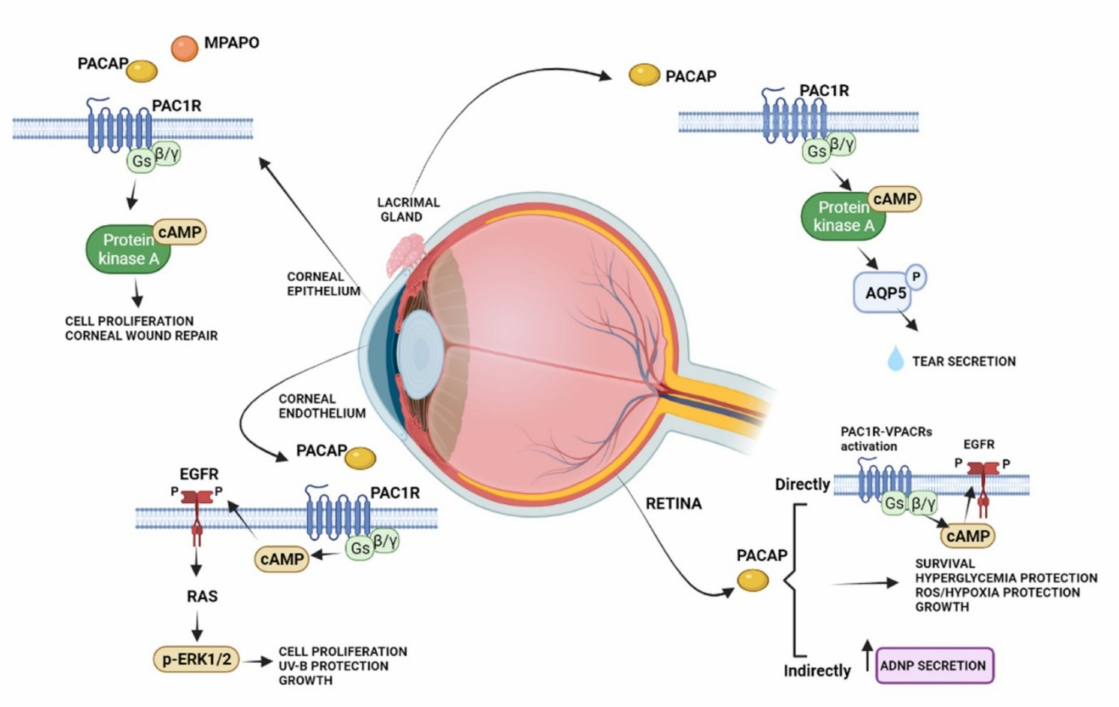
Figure 2. Schematic diagram showing the main pro-survival/antiapoptotic/protective intracellular pathways activated by PACAP in different ocular